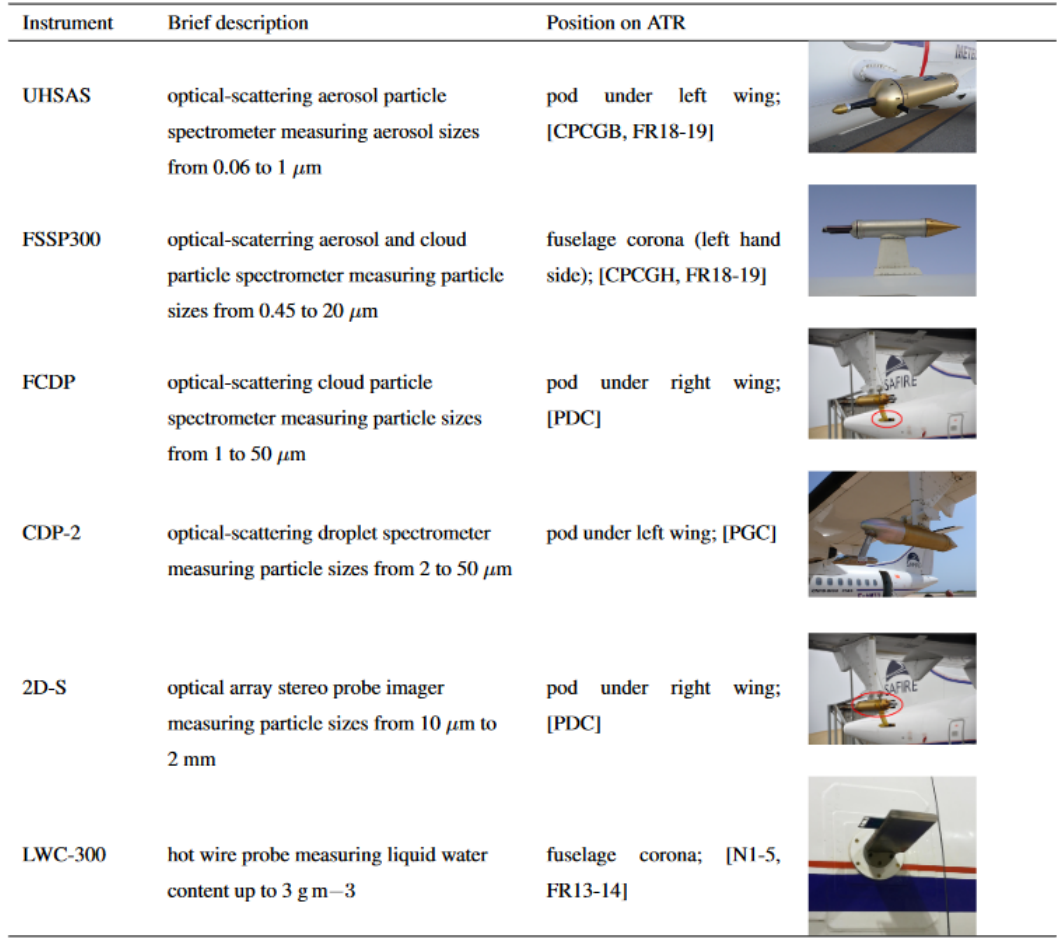
Table 8. Microphysical probes mounted on the ATR for EUREC 4 A. See Appendix D for the correspondence between the position on the aircraft and the ATR